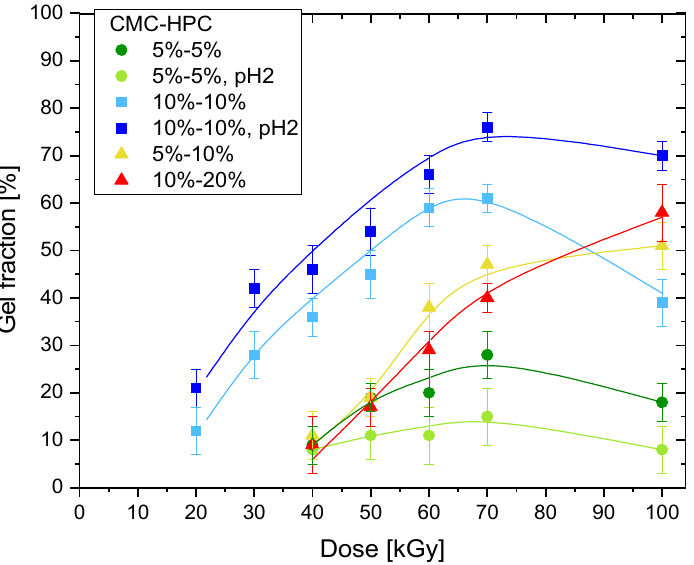
Figure 3. Gel fraction of hydrogels manufactured by irradiation of CMC–HPC in aqueous solutions. The GF array of HPC–CMC–PEGDA hydrogels, with the same polysaccharide con- tents and two crosslinker concentrations, is presented in Figure 4. The employment of the lowest irradiation dose of 5 kGy resulted in a GF of up to ca. 25% when 2.5% PEGDA was used, and the GF at the minimum dose was generally higher for gels formed with 5% crosslinker. This tendency is also continued throughout the following irradiation doses, although the insoluble fraction (for instance, 50% indicated in the graphs) increases earlier (at lower doses) for solutions with a higher PEGDA content. Exploring the influence of CMC on the gels, one may compare 2.5 and 5% CMC in the gels formed with 5% HPC for both contents of PEGDA—a higher concentration of CMC results in a higher GF. However, this is exceptional, because in the case of a higher HPC content, especially with a 10/10 polysaccharides ratio, the tendency is not obvious. The general observation is that moderate concentrations of polysaccharides in the triple-component system may be advantageous for obtaining practical gels. At low polysaccharide concentrations, the gels are weak, even at the highest absorbed doses. On the other hand, high polysaccharide concentrations result in gels of satisfactory properties at relatively low doses; nevertheless, they become brittle at the highest ones. It must be noted that high doses are required for such systems, because the unsaturated carbon–carbon bonds present in the crosslinker have to react completely to avoid any toxicity to the resulting hydrogel. The other reason that moderate concentrations are preferred is also straightforward preparation, i.e., the uniform mixing and complete dissolution of the components within reasonable time of 24 h, which is difficult to achieve for systems with high concentrations of macromolecular components. Although there were no direct examinations of gel stability, it may be speculated that they are stable since the autoclaving treatment (for the extraction of sol to evaluate the GF) demonstrated their dura- bility. Moreover, the known features of polysaccharides and gels manufactured with the same method (creating permanent, i.e., covalent bonds linking individual macromolecules) suggest stability [25]. The hydrolysis of polysaccharides proceeds relatively slowly, how- ever, if the medium contains enzymes, particularly cellulases, the degradation is quick [6]. The incorporation of the crosslinker will not change this character, assuming that it is the network of polysaccharide chains connected with the crosslinker, but not the network of PEGDA itself. Nowadays, biodegradation in nature is a desired feature for materials, and hydrogels based on cellulose fulfill this